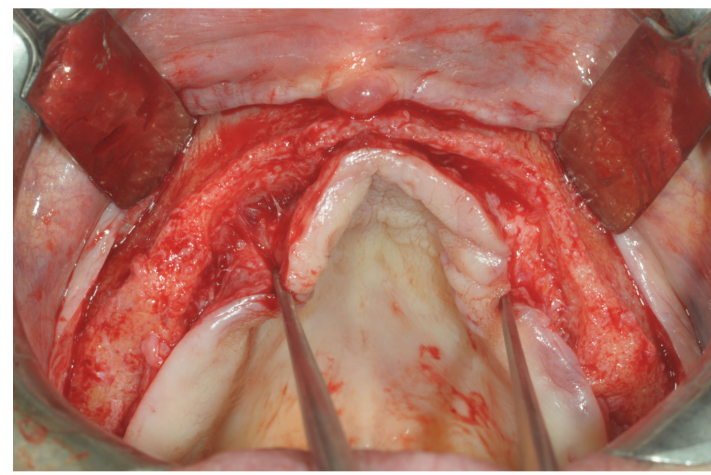
Figure 3. Intra-surgical view prior to horizontal GBR.